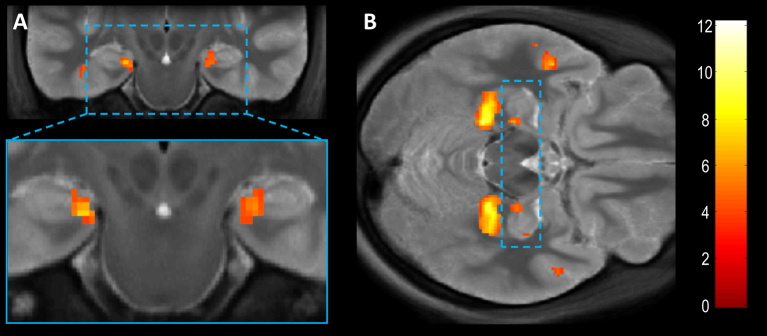
The response to scenes in anterior medial hippocampus and the wider volume. SPM whole-volume analysis testing for a stronger response to scenes than single isolated objects (collapsed over task). A. Coronal slice showing activation of anterior medial hippocampus (MNI y = −20). Inset, the medial temporal lobe enlarged for clarity. B. Axial slice showing hippocampi (blue box), PHC, STS and vmPFC. Images thresholded at p < .001 uncorrected for display purposes, overlaid on the group average T2 structural volume.